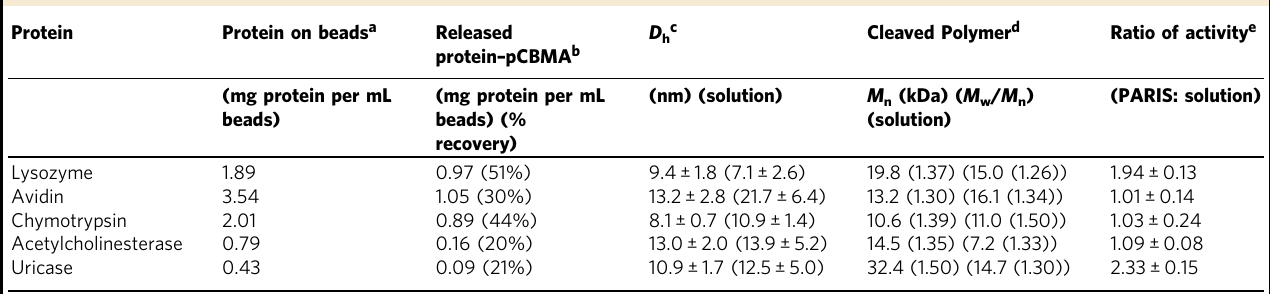
Table 5 PARIS synthesis and characterization of ranging proteins Protein Protein on beads a